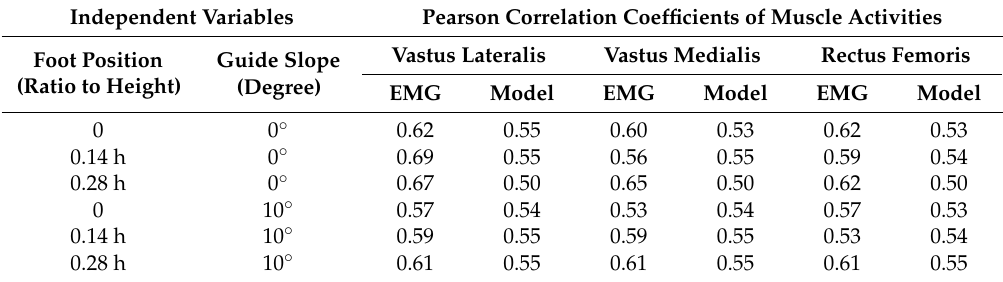
Table 4. Peak timing of maximum muscle activates of right leg measured by EMG sensors and simulated by